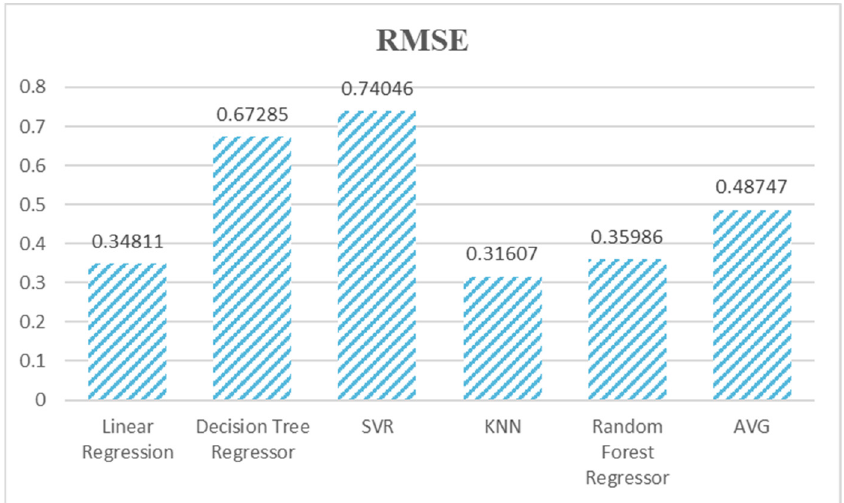
Figure 4. Root Mean Squared Error of five prediction models.